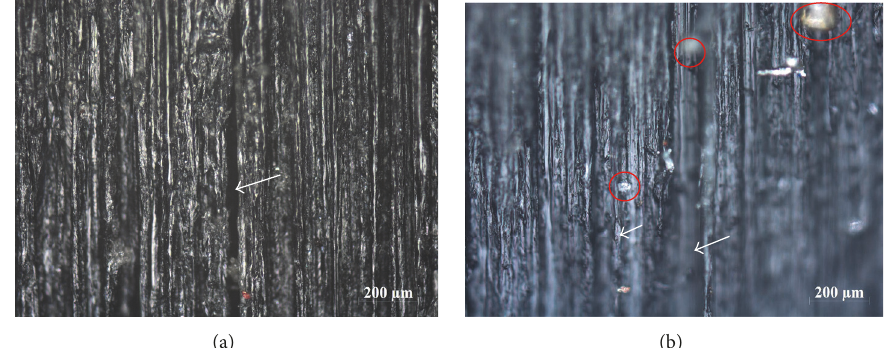
Figure 7: Micrographs of worn contact surface (counterface P240 and normal load 20 N): (a) extruded pins and (b) injection moulded pins.